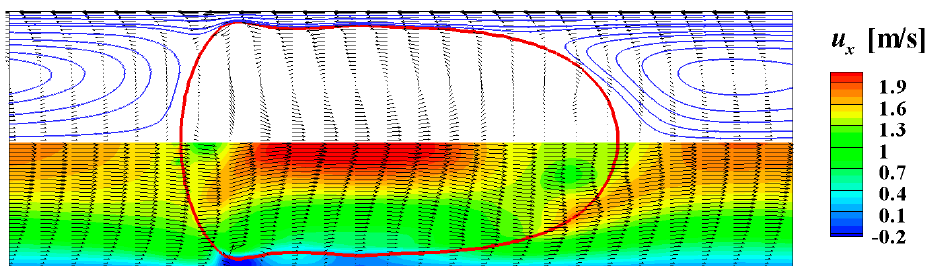
Figure 5. Computed quasi-steady bubble shapes (thick red lines) and velocity fields (vectors) in the fixed reference frame (lower half) and in the moving reference frame (upper half), identical to Case 2 in Woo et al. [46].